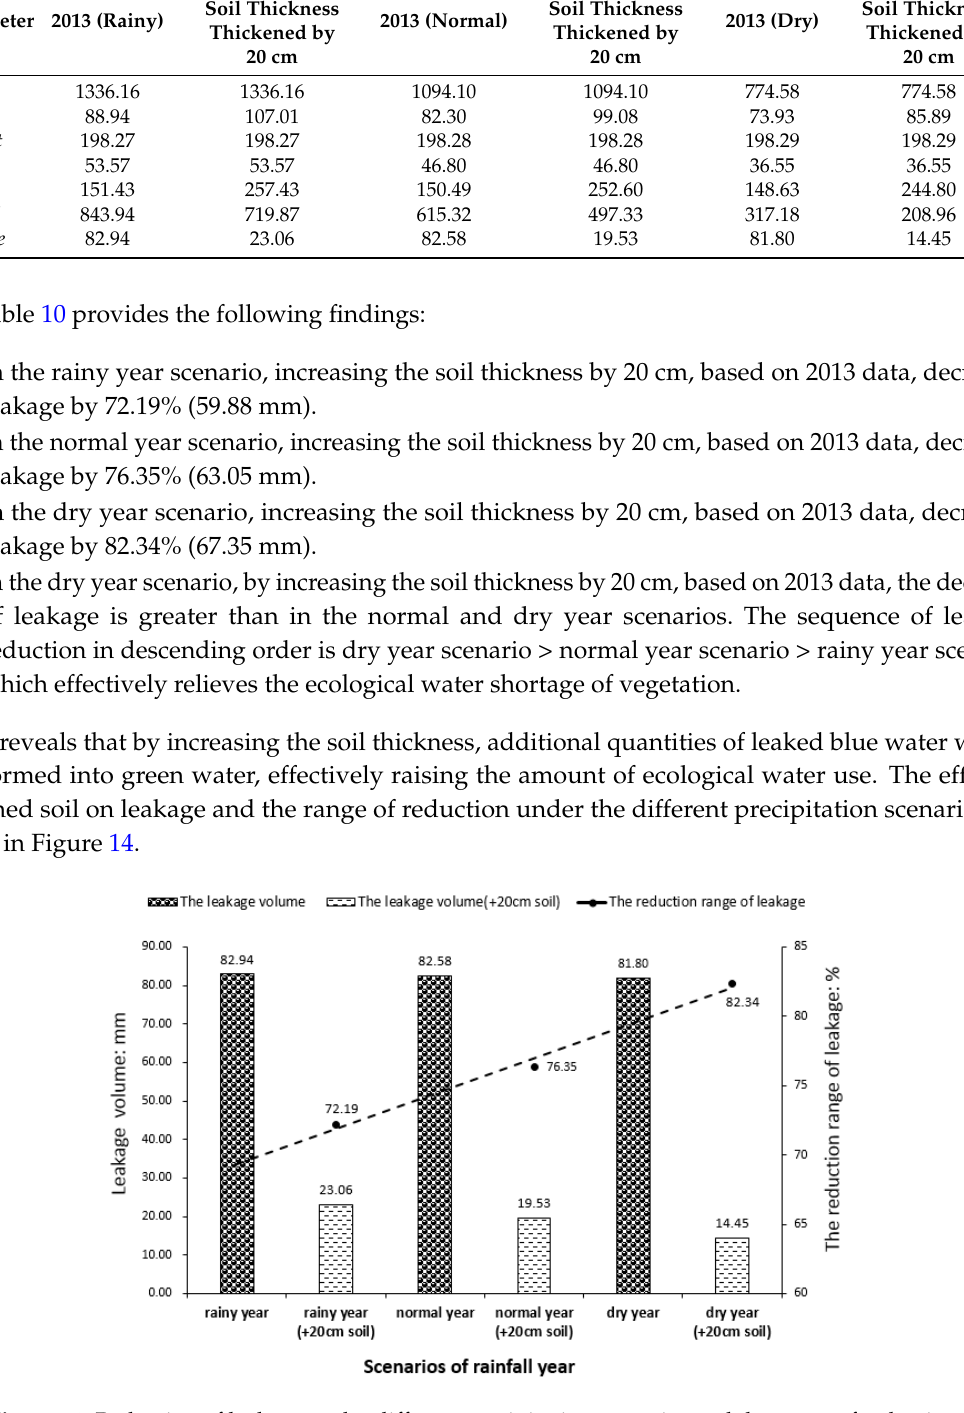
Figure 14. Reduction of leakage under different precipitation scenarios and the range of reduction.